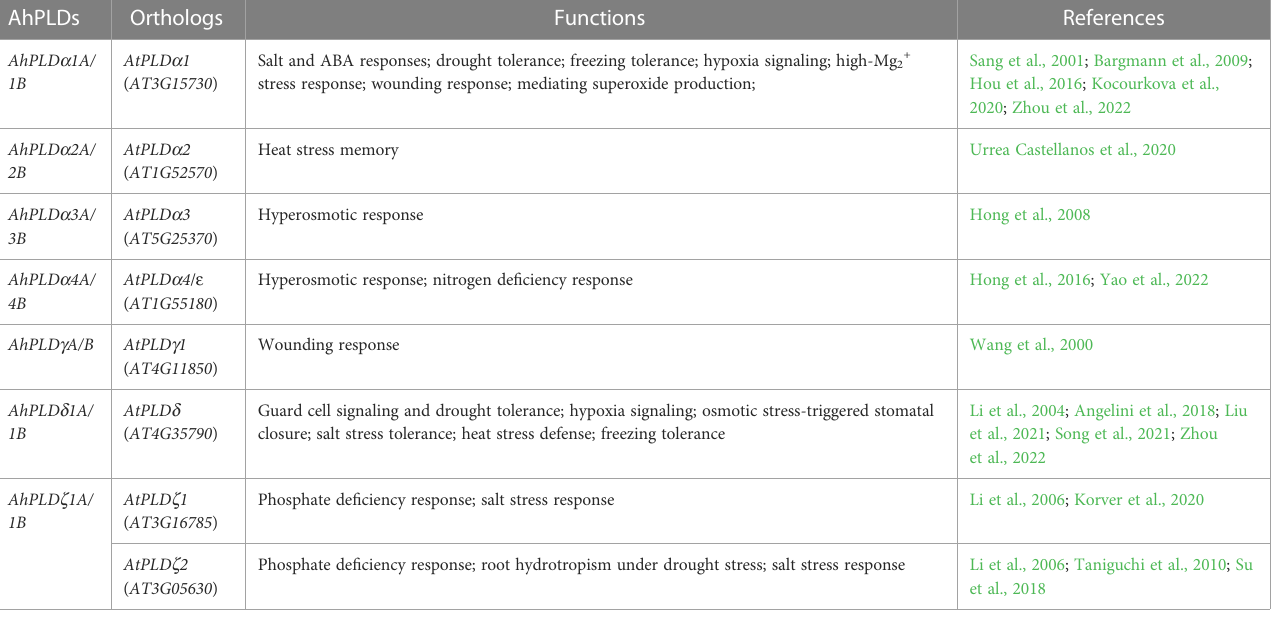
TABLE 2 Orthologous PLD genes in peanut and Arabidopsis with known abiotic stress tolerant functions.